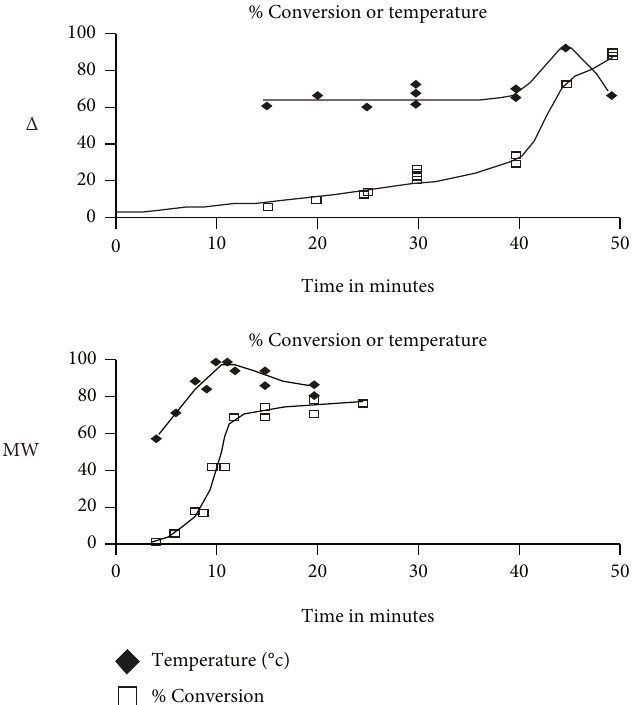
Figure 6: Conversion of methyl methacrylate and evolution of the temperature in the reaction mixture; Δ : by conventional heating; MW: microwave-assisted (reprinted from Chia et al. [47] with permission. Copyright ©1995, Elsevier